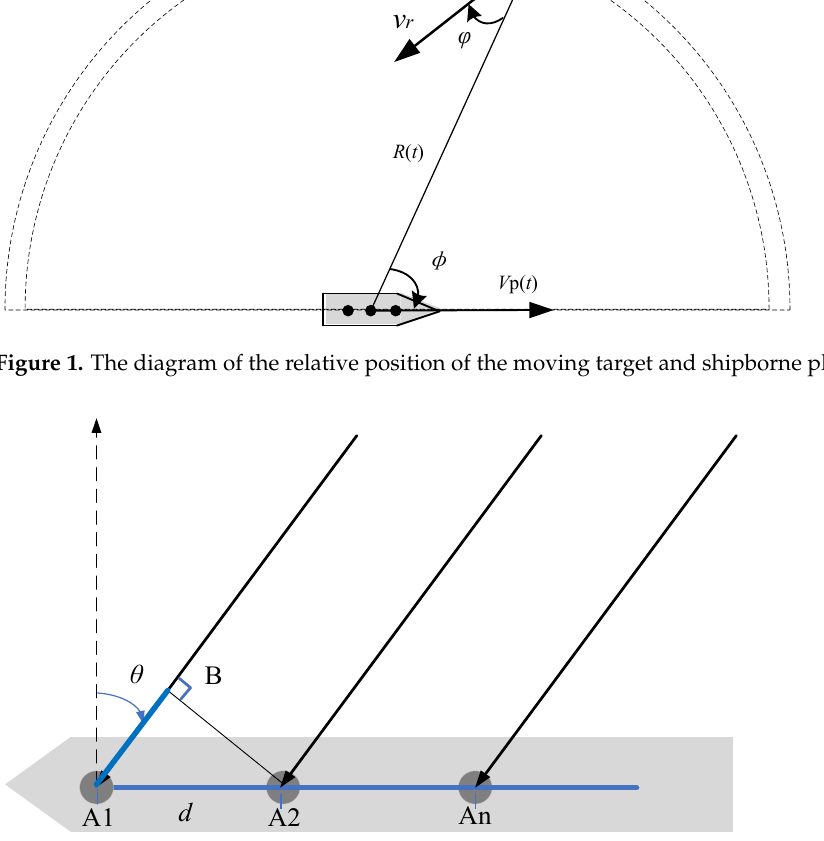
Figure 2. The physical model of shipborne HFSWR